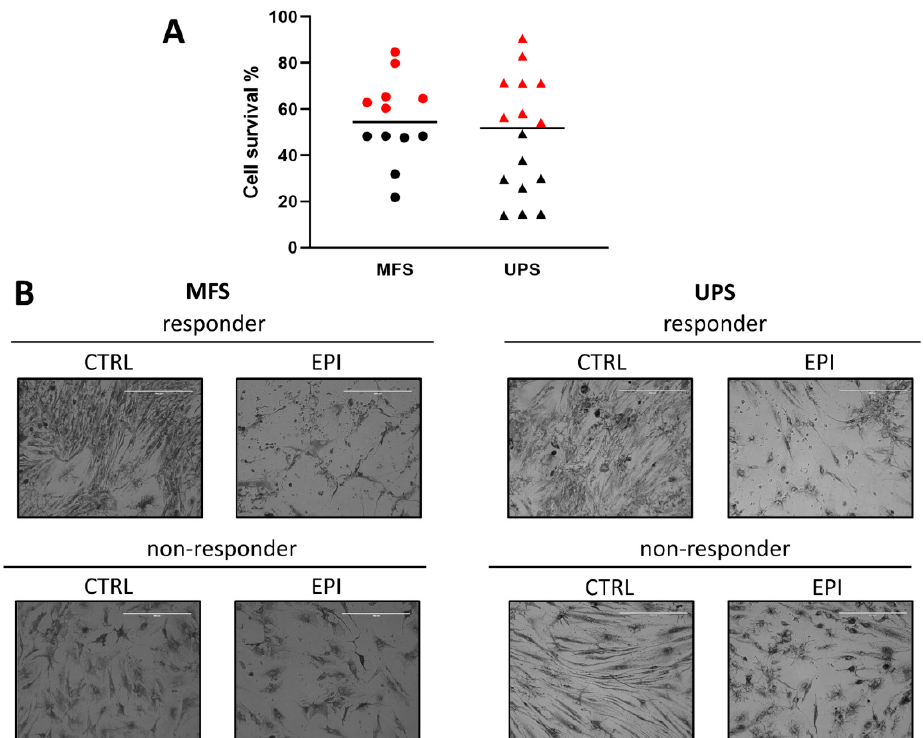
Figure 2. Pharmacological analysis of MFS and UPS patient-derived primary cultures exposed to anthracycline. ( A ) Scatter plot showing cell survival of MFS and UPS patient-derived cell lines treated with epirubicin. Black horizontal lines represent median value. Red symbols represent non-responders samples (NR), black symbols represent responders samples (R) according to an arbitrary threshold of 50% cell survival. ( B ) Representative light microscope images of responder and non-responder MFS and UPS patient-derived cell lines, untreated (CTRL) or exposed to epirubicin (EPI), 10× magnification.